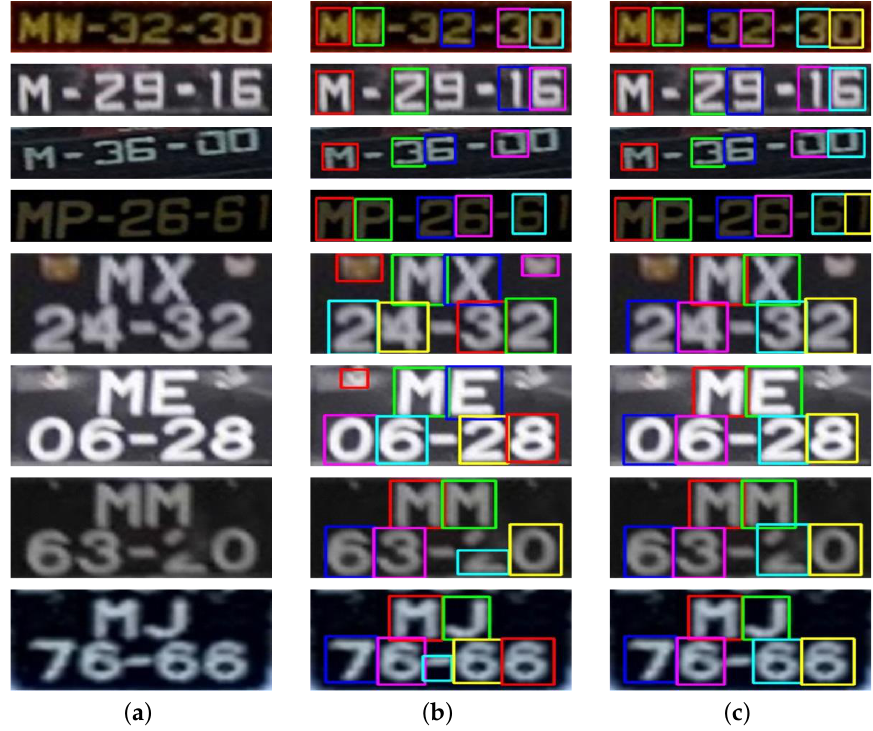
Figure 5. Some examples to show the function of TMPP. ( a ) Input images. ( b ) False positives or missing detections. ( c ) The results processed by